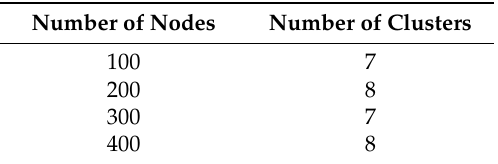
Table 2. Set covers number created by Greedy